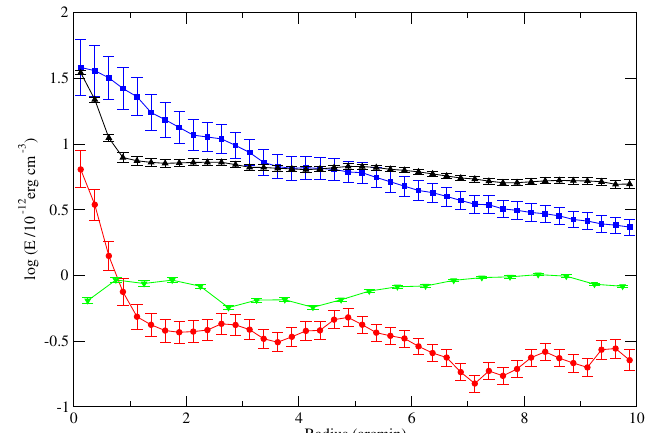
Figure 2. Radial variation of the energy densities in IC 342, determined from observations of synchrotron and thermal radio continuum and the COand H I line emissions: magnetic energy density of the total field B 2 tot /8 π (black triangles), identical to that of total cosmic rays; magnetic energy density of the ordered field B 2 /8 π (green triangles); kinetic energy density of the turbulent neutral ord gas E turb = 0.5 ρ n v turb 2 (blue squares), assuming a turbulent velocity v turb = 10 km/s, taken from the average velocity dispersion of the HIgas; and thermal energy density of the warm ionized gas E th = 1.5 n e k T e (red circles), where n e is the average thermal electron density and T e is the electron temperature ( T e ≈ 10 4 K). The error bars include only errors due to rms noise in the images from which the energy densities are derived. No systematic errors are included, e.g., those imposed by a radial variation of thermal gas temperature, filling factor or turbulent gas velocity, nor errors due to deviations from the equipartition assumption. At the distance of 3.5 Mpc, 1 arcmin corresponds to 1.0 kpc (from